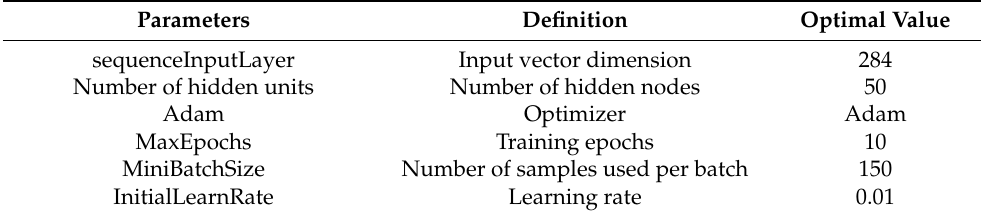
Table 1. BiLSTM network model parameters.